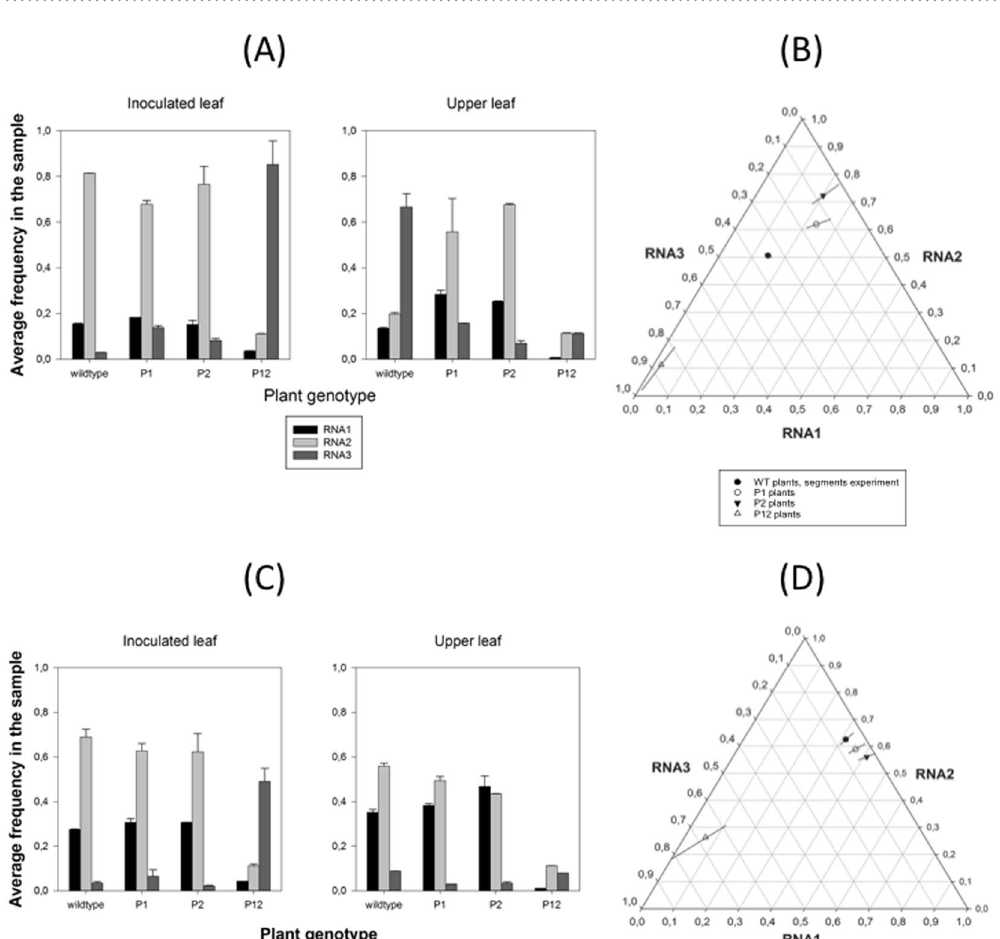
Figure 4. Accumulation of the three genomic segments of AMV on transgenic N. benthamiana plants that express viral proteins P1, P2 or both. ( A ) Experimental determinations (by RT-qPCR) of the frequency of each AMV genomic in total RNA extractions from five different host species. Bars represent the mean of n = 3 plants; error bars represent ± 1 SEM. ( B ) Normalized frequency ternary plot showing the effect of transgenic expression of viral RNAs in the estimated SGF . ( C ) As in ( A ) but determined for encapsidated RNAs. ( D ) As in ( B ) but for encapsidated